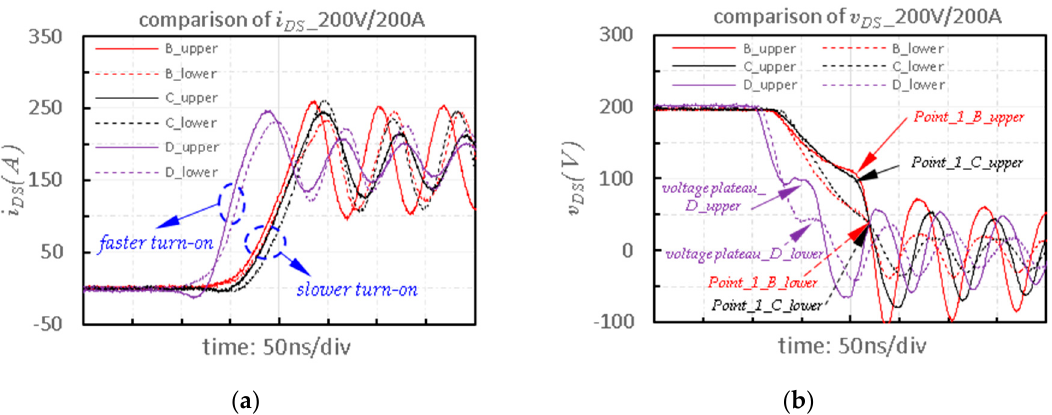
Figure 9. The turn-on transient waveforms of SiC high-power modules under condition of low V DD : ( a ) waveform of i DS , ( b ) waveform of v DS .